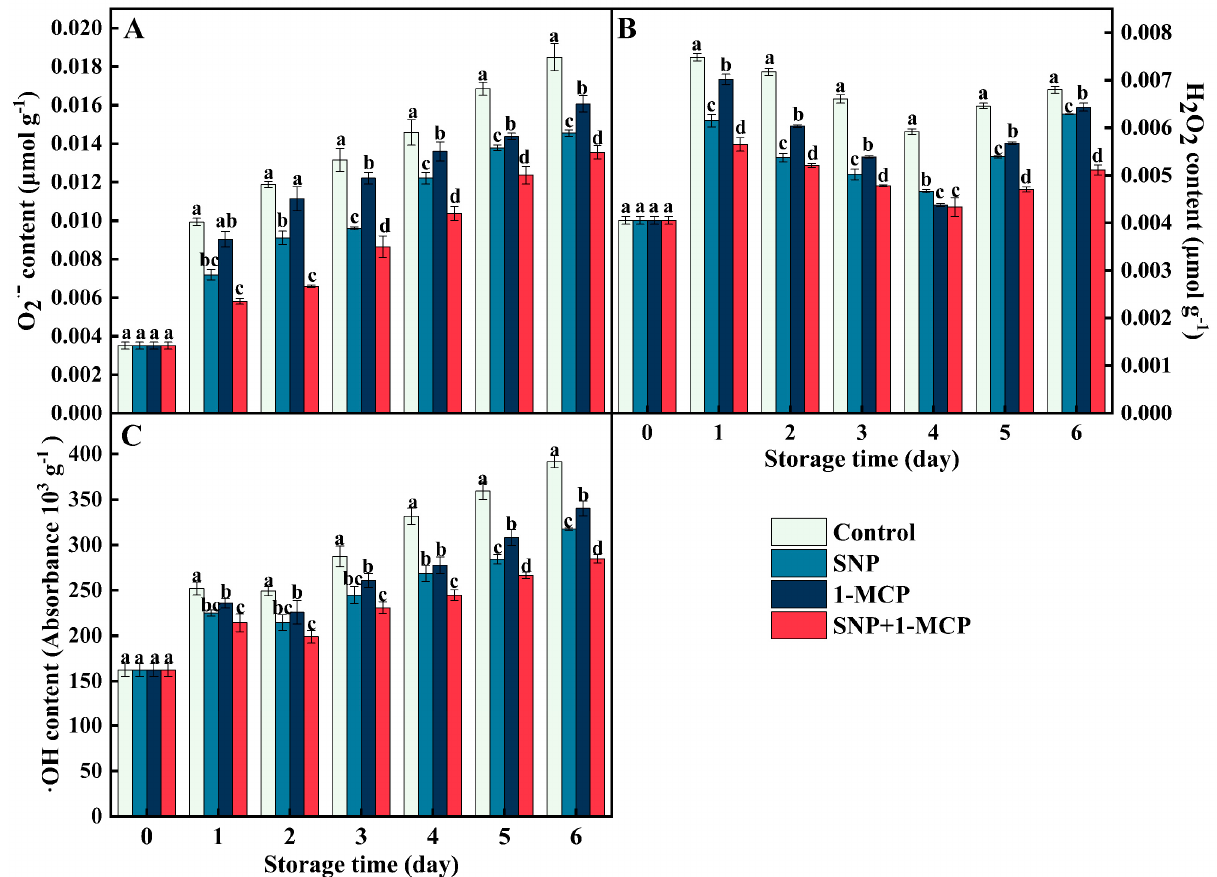
Figure 2. ( A ) Superoxide (O 2· − ), ( B ) hydrogen peroxide (H 2 O 2 ), and ( C ) hydroxyl radical (·OH) contents of Agaricus bisporus at 25 °C. The letters indicate the significant difference ( p < 0.05), and the bars indicate standard error (means ± SE).